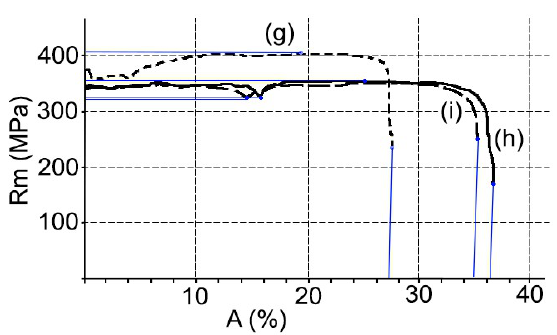
Figure 5. Metallographic images of DX51D steel, ( a ) detail of Al-Si coating in a set-up of sheets; ( b ) microstructure in supply state; ( c ) microstructure after thermal cycle 1; ( d ) microstructure after thermal cycle 2.